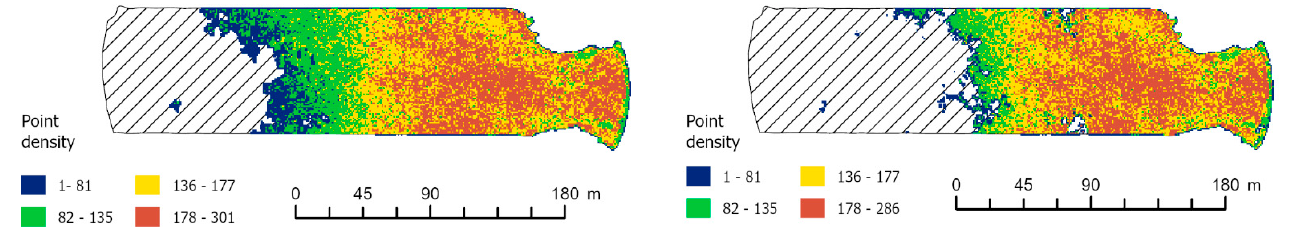
Figure 7. Density of point cloud per 1 m 2 for the PCA cloud ( left ) and the PCG cloud ( right ).